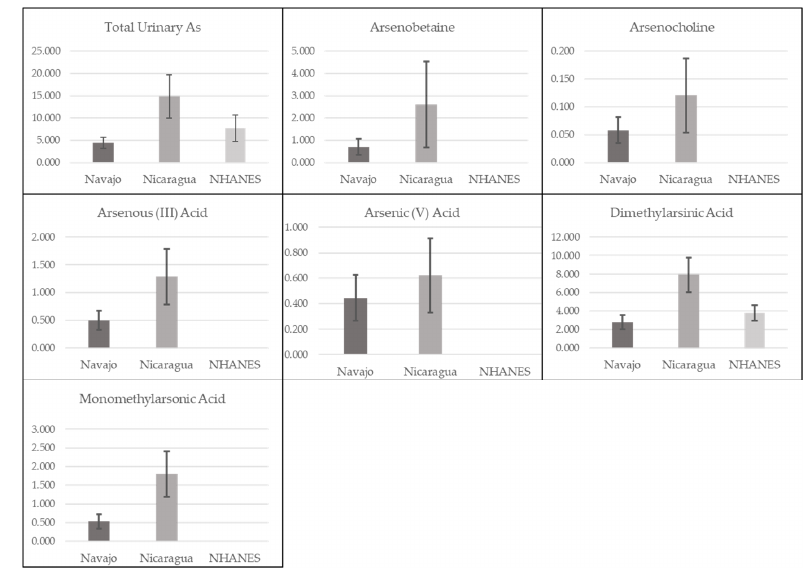
Figure 2. Distribution of geometric mean total and speciated arsenic concentrations (µg/g creatinine) and 95% confidence limits in comparison with geometric mean concentrations of the United States adult male population 2011–2012 [59]. Note: Arsenic is reported in µg/L arsenic.